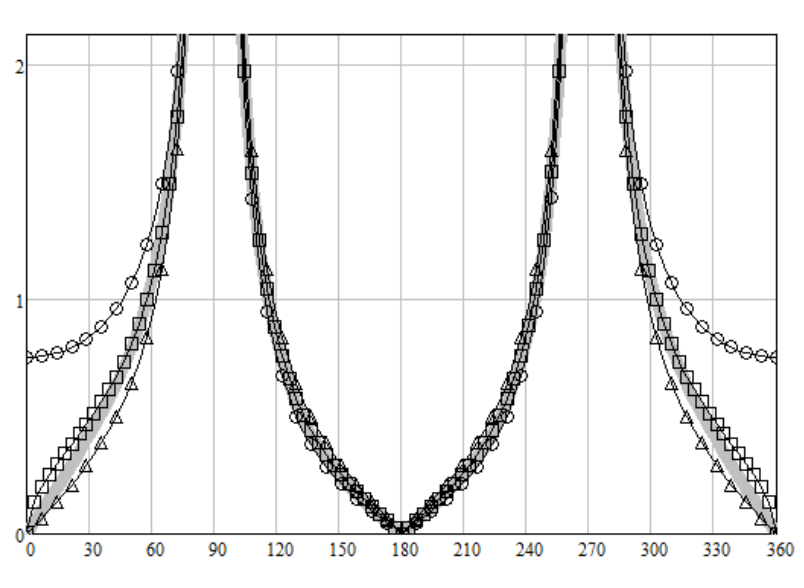
Figure 2. The scattering diagrams (SD) modules for Х = 300, х ( Х ) = 0.549, and φ 0 = 90 are plotted along the vertical axis. Circles—GDC (5), triangles—PODC (6), solid gray line—WHM solution gr ( X , φ , φ 0 ) (2), and squares—heuristic solution gh ( R , T , φ , φ 0 ) (8).